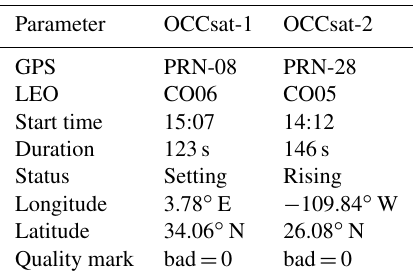
Table 3. Details of parameters of the two selected GPS occultation events on 12 December 2013.